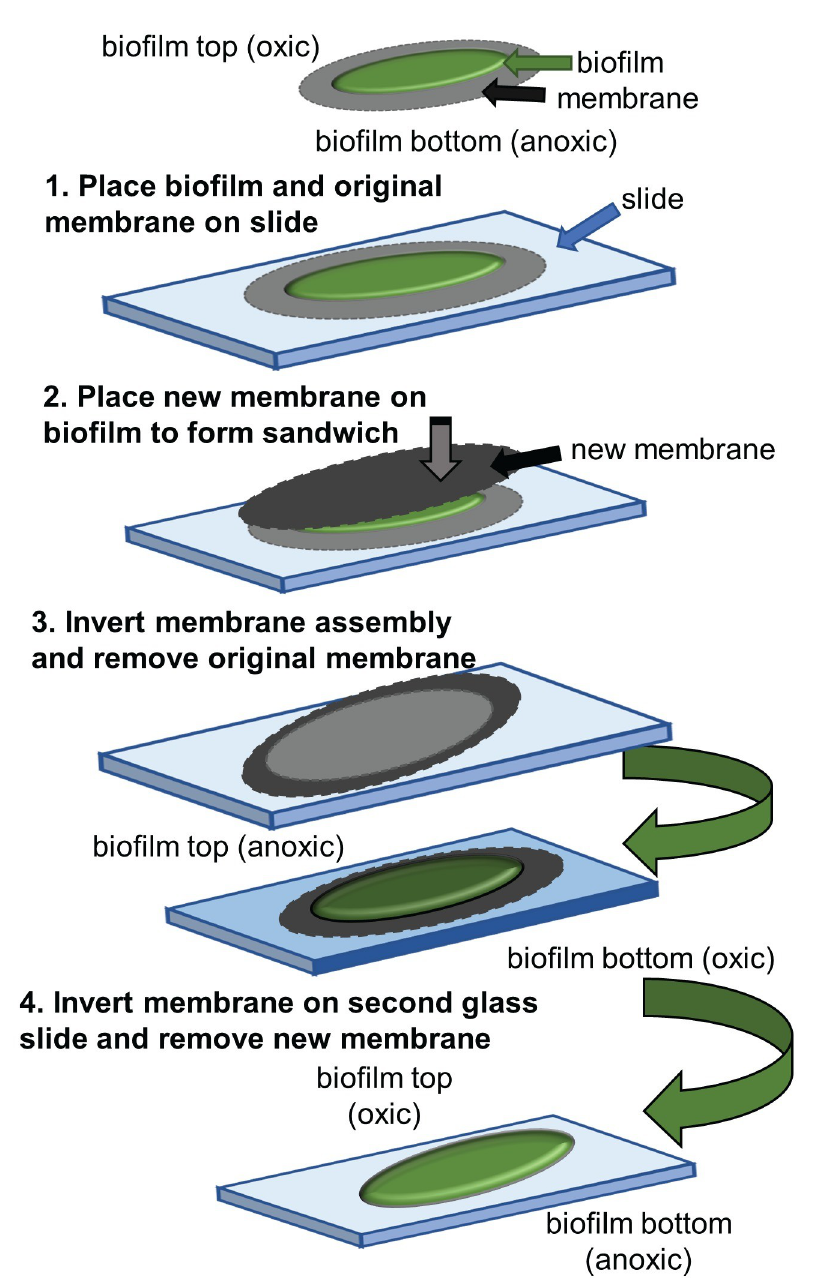
Fig 3. Technique for exposing oxic side of biofilm. The exposed, oxic side of a biofilm grown on its original membrane was placed on a glass slide, then covered with a new membrane. The membrane-biofilm sandwich was inverted to peel off the old membrane. The exposed anoxic side on the new membrane was then inverted onto a second glass slide. Removal of the new membrane exposed the oxic surface for ablation. Approximately 200 ng of digested peptides resuspensions were separated through nano-LC (1260 Infinity LC System, Agilent, Santa Clara, CA) with a C18 column (Agilent, Zorbax 300SB, and column dimensions of 150 mm length × 75 μ m internal diameter, with 3.5 μ m pore size particles) and a 90-min increasing organic gradient from 7% to 95%. The aqueous